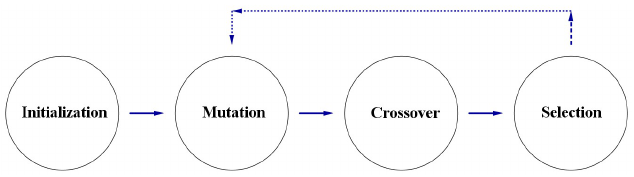
Figure 2. Usual stages of DE search algorithm.